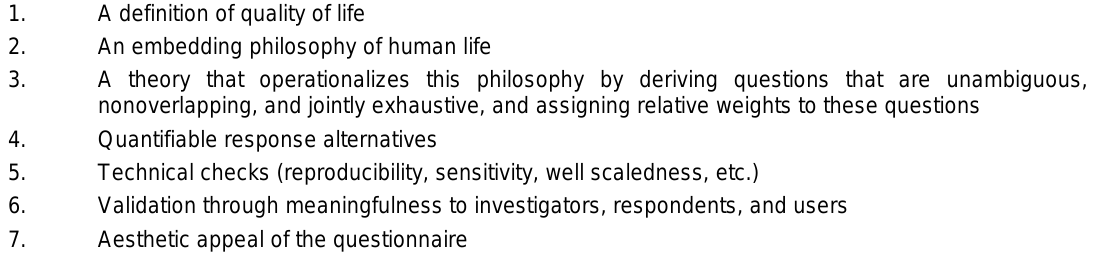
Seven Criteria or Requirements for a Quality-of-Life Concept that can Provide a